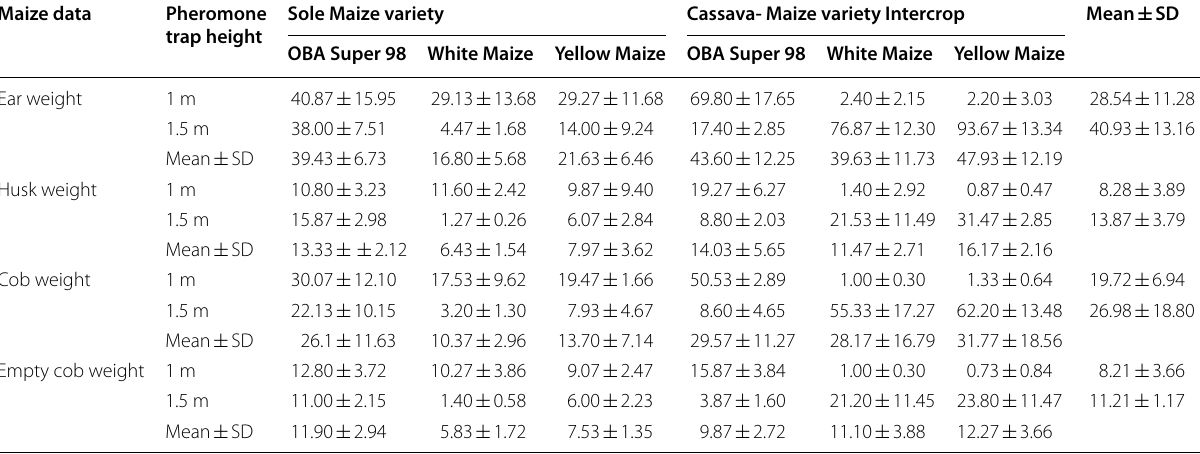
Table 4 Yield and yield components of dry maize grains in maize-cassava cropping pattern infested by Fall Army Worm cultivated in the Niger Delta Region of Nigeria under two pheromone heights as a means of determining population